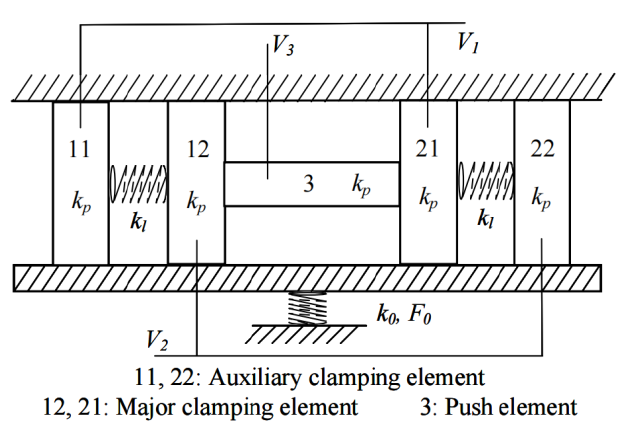
Figure 3. Sketch view of advanced inchworm piezoelectric motor.